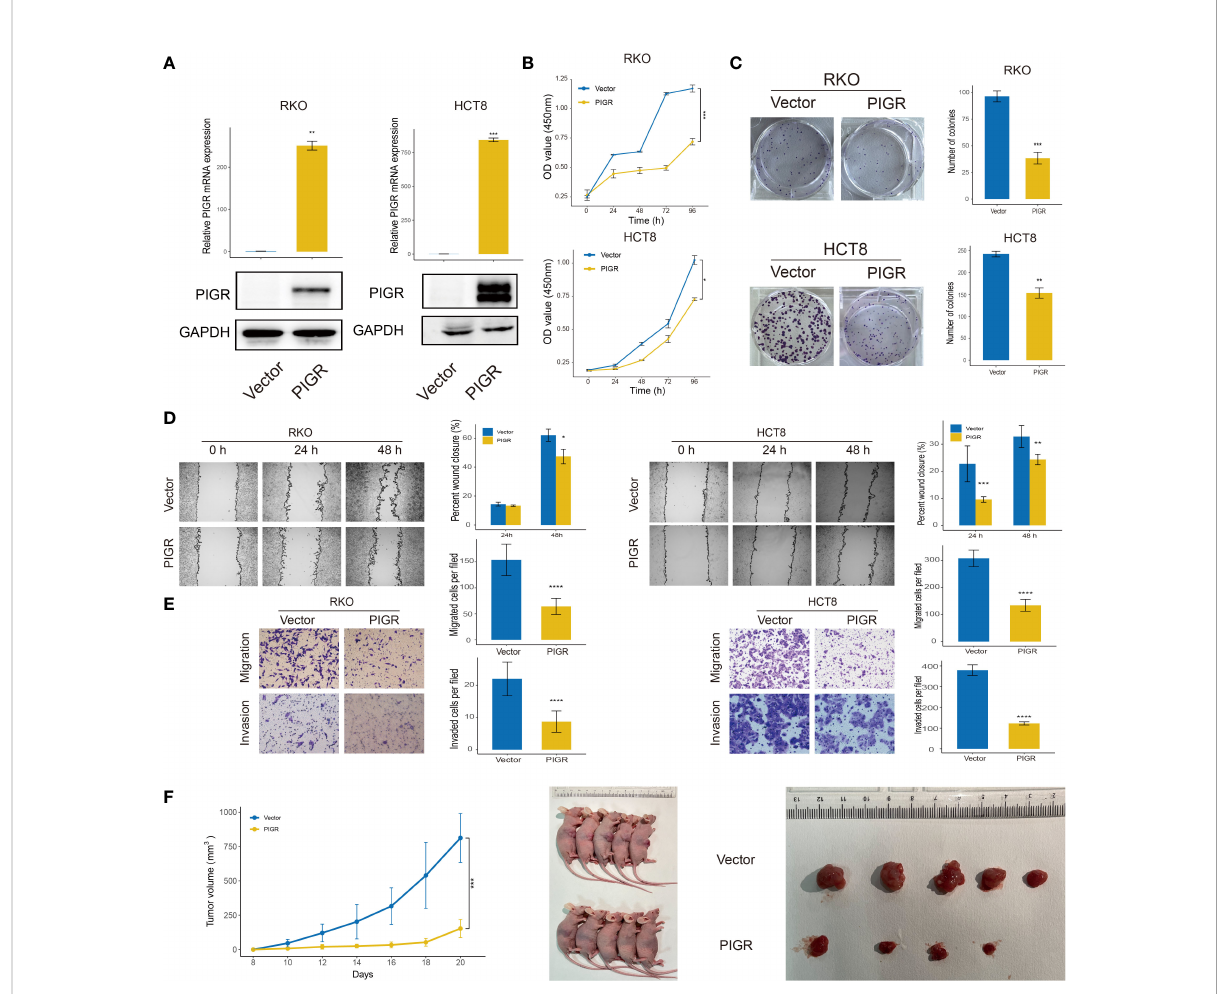
FIGURE 2 PIGR inhibits cell proliferation, migration and invasion (A) Overexpression of PIGR was con fi rmed by qRT-PCR and western blot in RKO and HCT-8 cells (n = 3; Student ’ s t-test). (B) Cell proliferation was detected by CCK-8 assay at 0, 24, 48, 72 and 96 hours in RKO and HCT-8 cells (n = 3; Student ’ s t-test). (C) The colony formation assay of RKO and HCT-8 cells (n = 3; Student ’ s t-test). (D, E) Wound healing, migration, and invasion assays after PIGR overexpression in RKO and HCT-8 cells (n = 3; Student ’ s t-test). (F) Effects of PIGR-overexpressing on RKO cells growth by establishment of subcutaneous xenograft mouse models. Tumor size and tumor growth curve are shown (n = 5; Student ’ s t-test). Data are presented as the mean ± S.D. * P < 0.05; ** P < 0.01; *** P < 0.001; **** P <